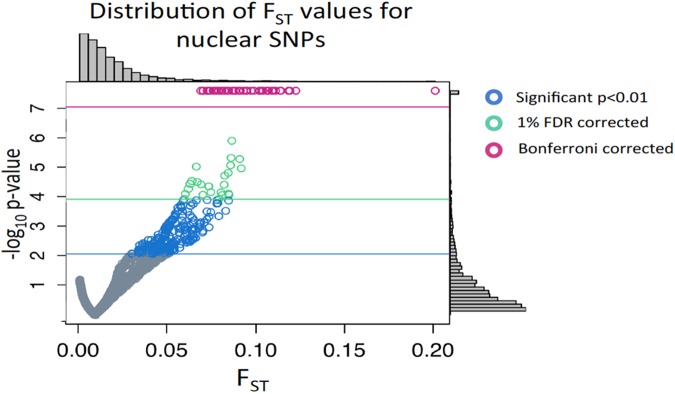
Distribution of wFST values for nuclear SNPs calculated between the two mt-haplotypes within the single MK population.Although we are examining a single population, we use the two mt-haplotypes as artificial populations for wFST calculations. Plot contains wFST values and corresponding negative log10 p-values -log10(0.01) = 2). Blue values are significant with a p-value <0.01, green values are significant with a 1% FDR correction, and purple values are significant with a Bonferroni correction. Histograms show wFST and p-value distributions.